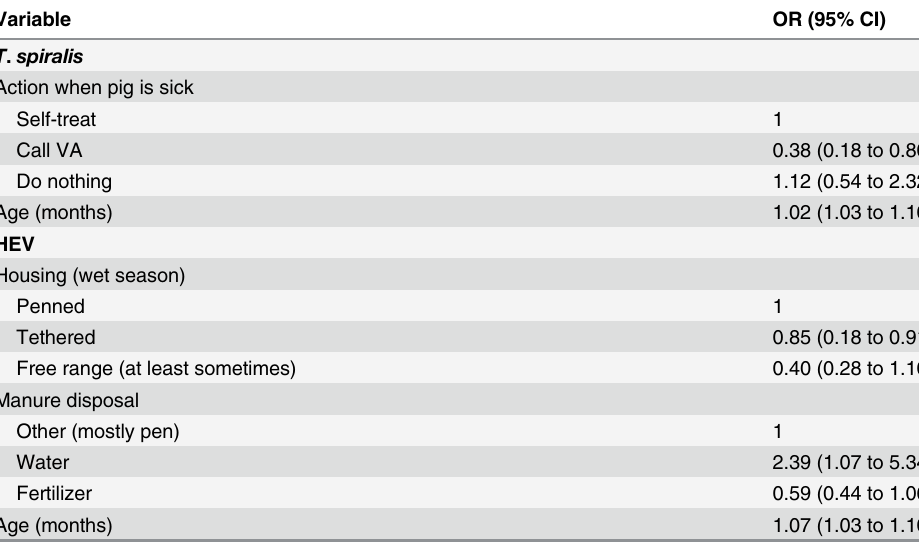
Table 4. Regression analysis of risk factors for pig seropositivity for T . spiralis and